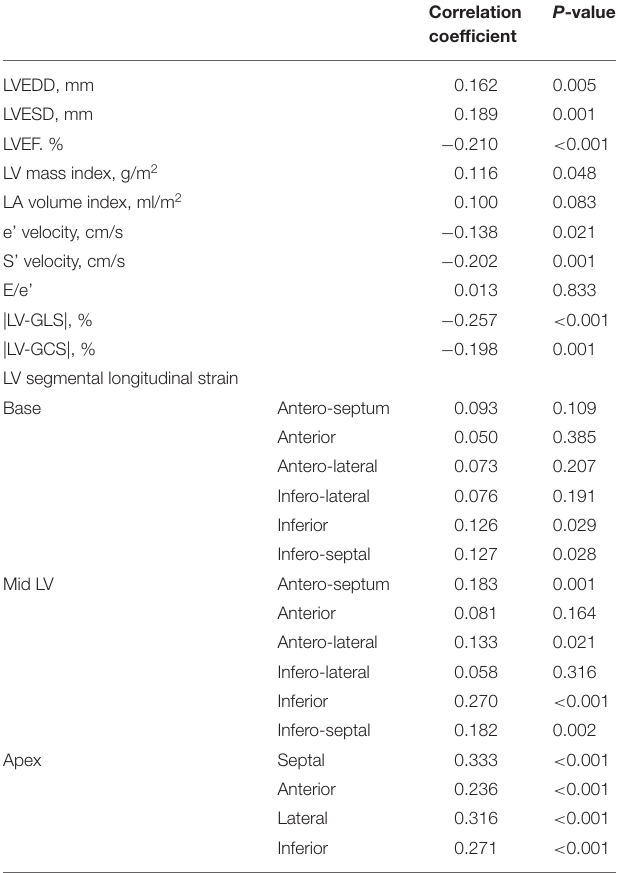
TABLE 3 | Simple correlations between pacing percentage and echocardiographic variables after PM implantation.